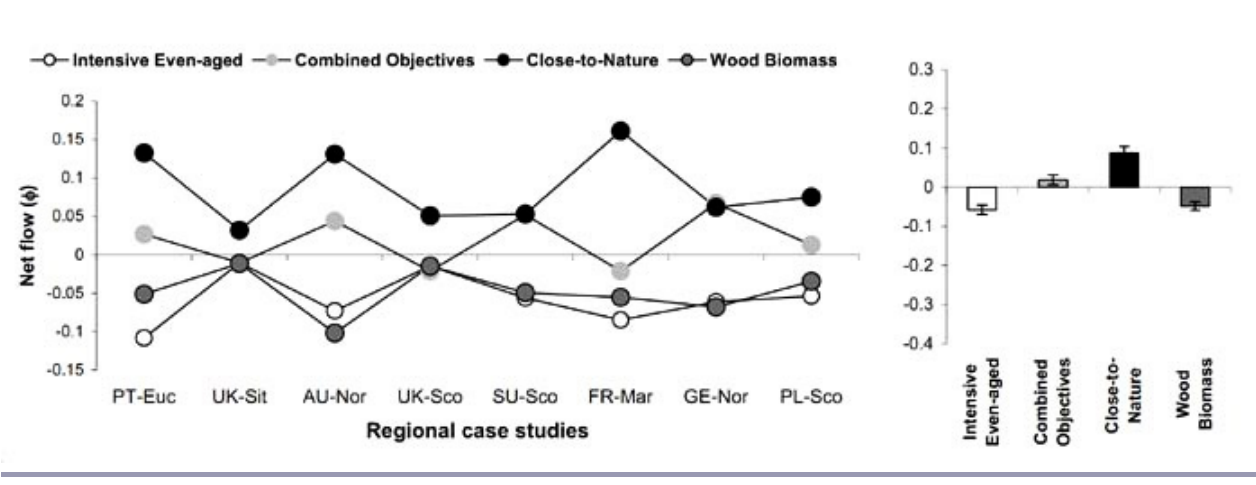
Fig. 5. Ranking of FMAs according to impact on biological damage by main hazards (irrespective of forest stand values at stake), across eight different regional case studies (left-hand side) and for overall results (right-hand